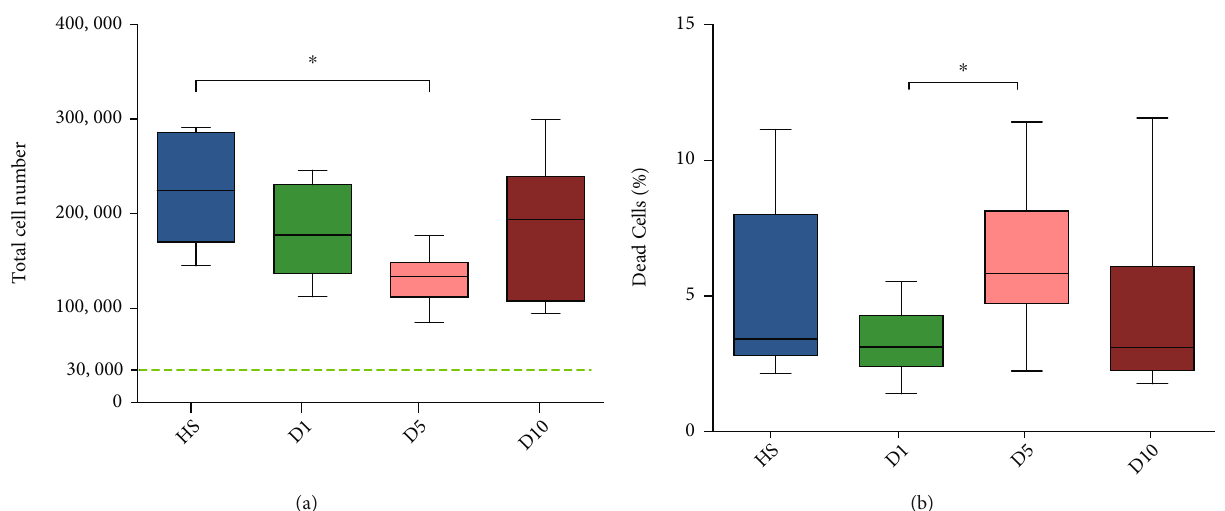
Figure 3: Evaluation of the proliferation capacity and viability of stem cells after cultivation in medium containing di ff erent sera (HS, D1, D5, or D10) for 72 hours. (a) Proliferation of hBMSCs treated with HS, D1, D5, or D10 serum. The green, dotted line shows the number of seeded cells (30,000 cells). Addition of serum from D5 to the culture medium resulted in a signi fi cantly lower proliferation of hBMSCs after 72 hours compared to HS. (b) Amount of dead cells after treatment with HS, D1, D5, or D10 serum. The D5 group demonstrated a signi fi cantly increased ratio of dead cells in comparison to D1. ∗ p ≤ 0 : 05 ( n = 4 ; N = 3 ).